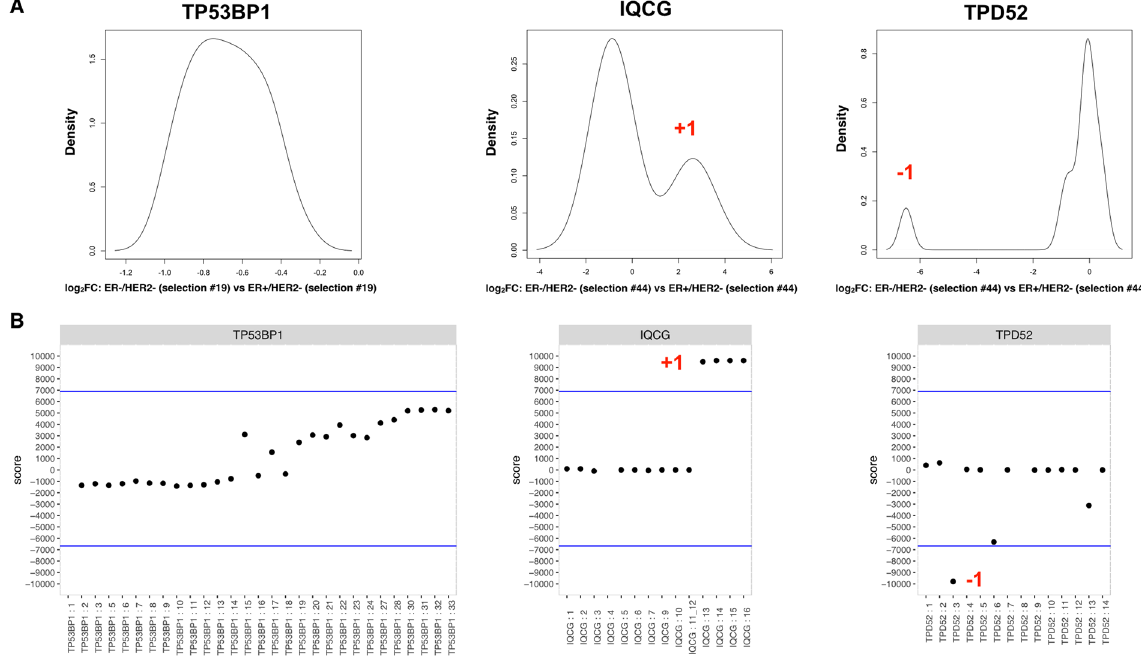
Figure 1. Method of analysis. ( A ) The difference in mode expression between exons in two biological groups (ER + HER2 − , ER − HER2 − , HER2 + , and NBS) was computed as the log 2 FC for each exon of a gene and the distribution (density plot) of log 2 FC for all exons in each gene was plotted. The density plots shown for TP53BP1, TPD52 , and IQCG compares one selection of 60% of ER + HER2 − samples to one 60% selection of ER − HER2 − samples, and was repeated 100 times for each pairwise comparison. The highest peak represents an overall scaling effect, affecting the majority of exons. Genes not affected by differential splicing will have only one peak, as shown for TP53BP1 . The remaining exons, i.e. those in peaks with smaller amplitude, were identified as exons that are differentially spliced or transcribed. Peaks to the right ( IQCG ) indicate exons with greater log 2 FC compared to the exons in the central peak. Peaks to the left of the central peak ( TPD52 ) are exons with smaller log 2 FC than the exons in the central peak. Log 2 FC was calculated for random selections of 60% of all samples within a biological class 100 times. For each test an exon was called either + 1, − 1, or 0, so that each exon was tested 10.000 times, and the total score for each exon was determined. The total scores for each exon in the three genes, TP53BP1, IQCG , and TPD52 when comparing ER − Her2 − and ER + HER2 − samples are shown in ( B ). Exons with scores exceeding 3 standard deviations (blue line) were called in the final